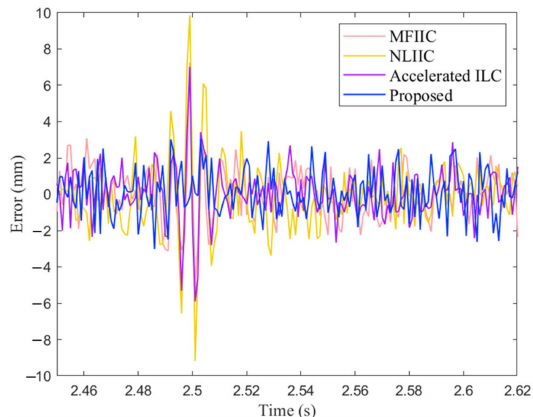
Figure 10. Steady state levitation tracking error